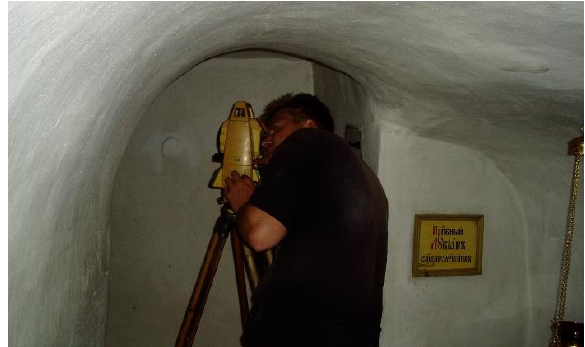
Fig. 3. Performance of geodetic measurements in caves For the georeferencing of the scanning data, the "free station" method was used (Fig. 4.).